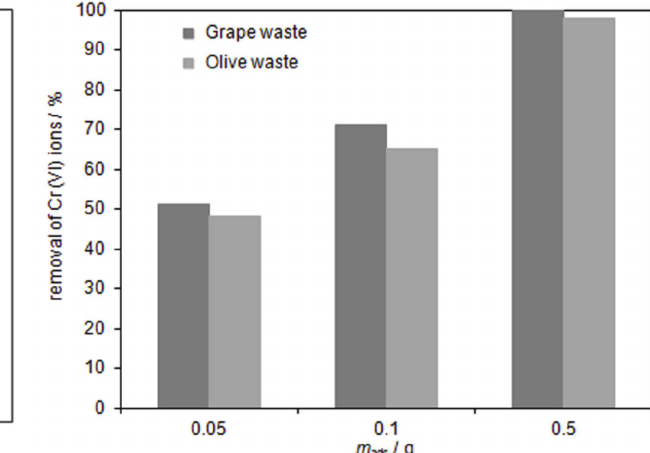
Fig. 5 – Concentration of chromium species at different pH values determined in experiment and modeled in MINTEQ soft- ware (γ (Cr(VI) = 60 mg dm –3 , V = 100 cm 3 , m (grape waste) 0 0 = 0.5 g and T = 20 °C)